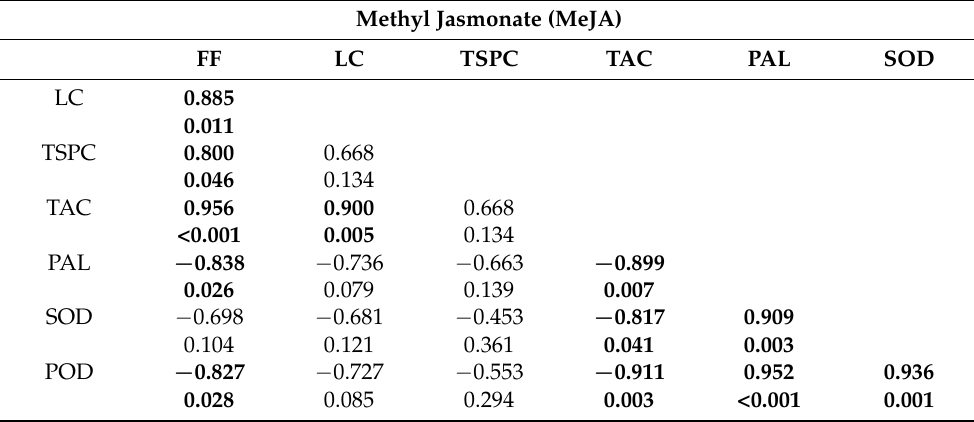
Table 2. Pearson’s correlation coefficients ( r ) and their corresponding significance levels ( p ) amongst 7 fruit measures on apricot cultivar ‘Bergarouge’ for inoculated fruits with methyl jasmonate ment days 0, 2, 4, 6 and 8 in the SL storage period. Bold figures represent the significant ( p < 0.05) correlation coefficient